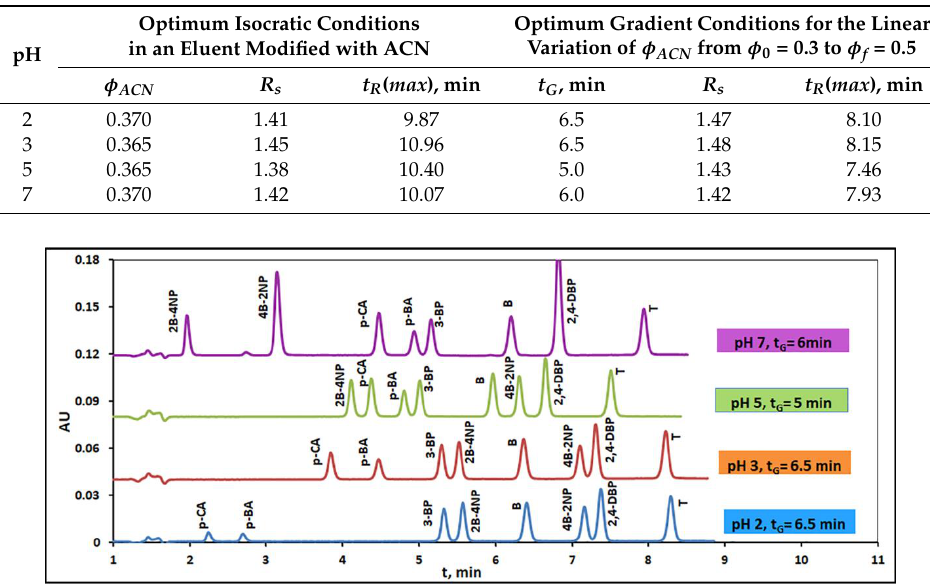
Figure 4. UV detected chromatograms of the mixture of 8 ionized and non-ionized solutes obtained on Kinetex 5 µ m EVO column under optimal gradient conditions in different eluent pHs. The elution order of solutes is shown in the Figure. See Table 1 for details of optimal gradient